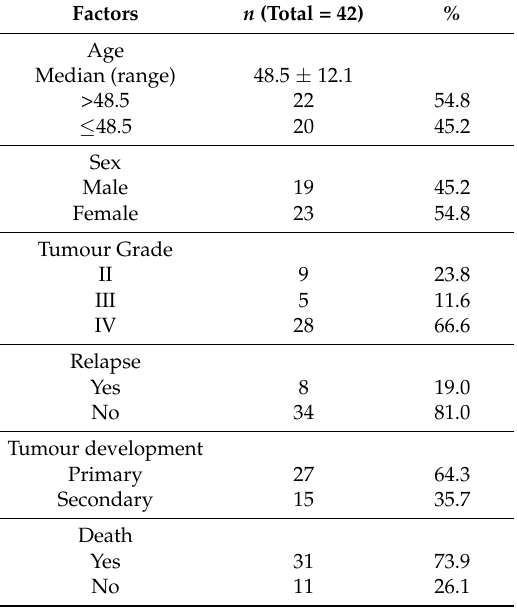
Table 2. Clinical characteristics of patients used in the present